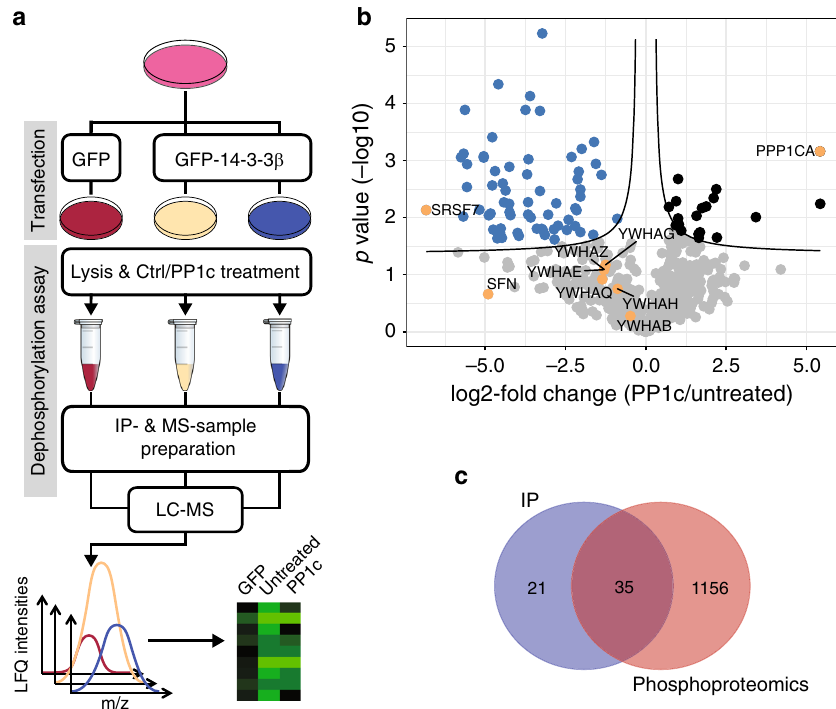
Fig. 7 PP1 is a major regulator of 14-3-3 binding proteins. a Work fl ow of GFP-14-3-3 β IP and subsequent MS analysis to identify 14-3-3-interacting proteins regulated by PP1. b Volcano plot of pairwise comparison between untreated/PP1c-treated samples (two-tailed Student ’ s t test, FDR 0.05). Proteins labeled in blue showed signi fi cant dissociation from 14-3-3 upon PP1c treatment and in orange represent SRSF proteins also identi fi ed in Table 1, 14 – 3 – 3 isoforms, and PP1 (added as recombinant protein). c Venn diagram showing overlap between the 56 proteins signi fi cantly dissociating from 14-3-3 upon PP1c treatment (but not binding GFP alone) compared to signi fi cantly dephosphorylated proteins (1967 p-sites on 1191 proteins) found in the PP1 phosphoproteomic experiments (t-test untreated vs. PP1 treated, see also Supplementary Fig. 4b and Supplementary Data 2,